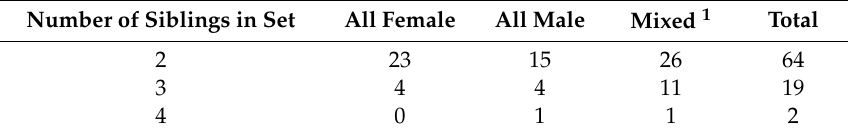
Table 5. Number of paired names with commonalities between siblings